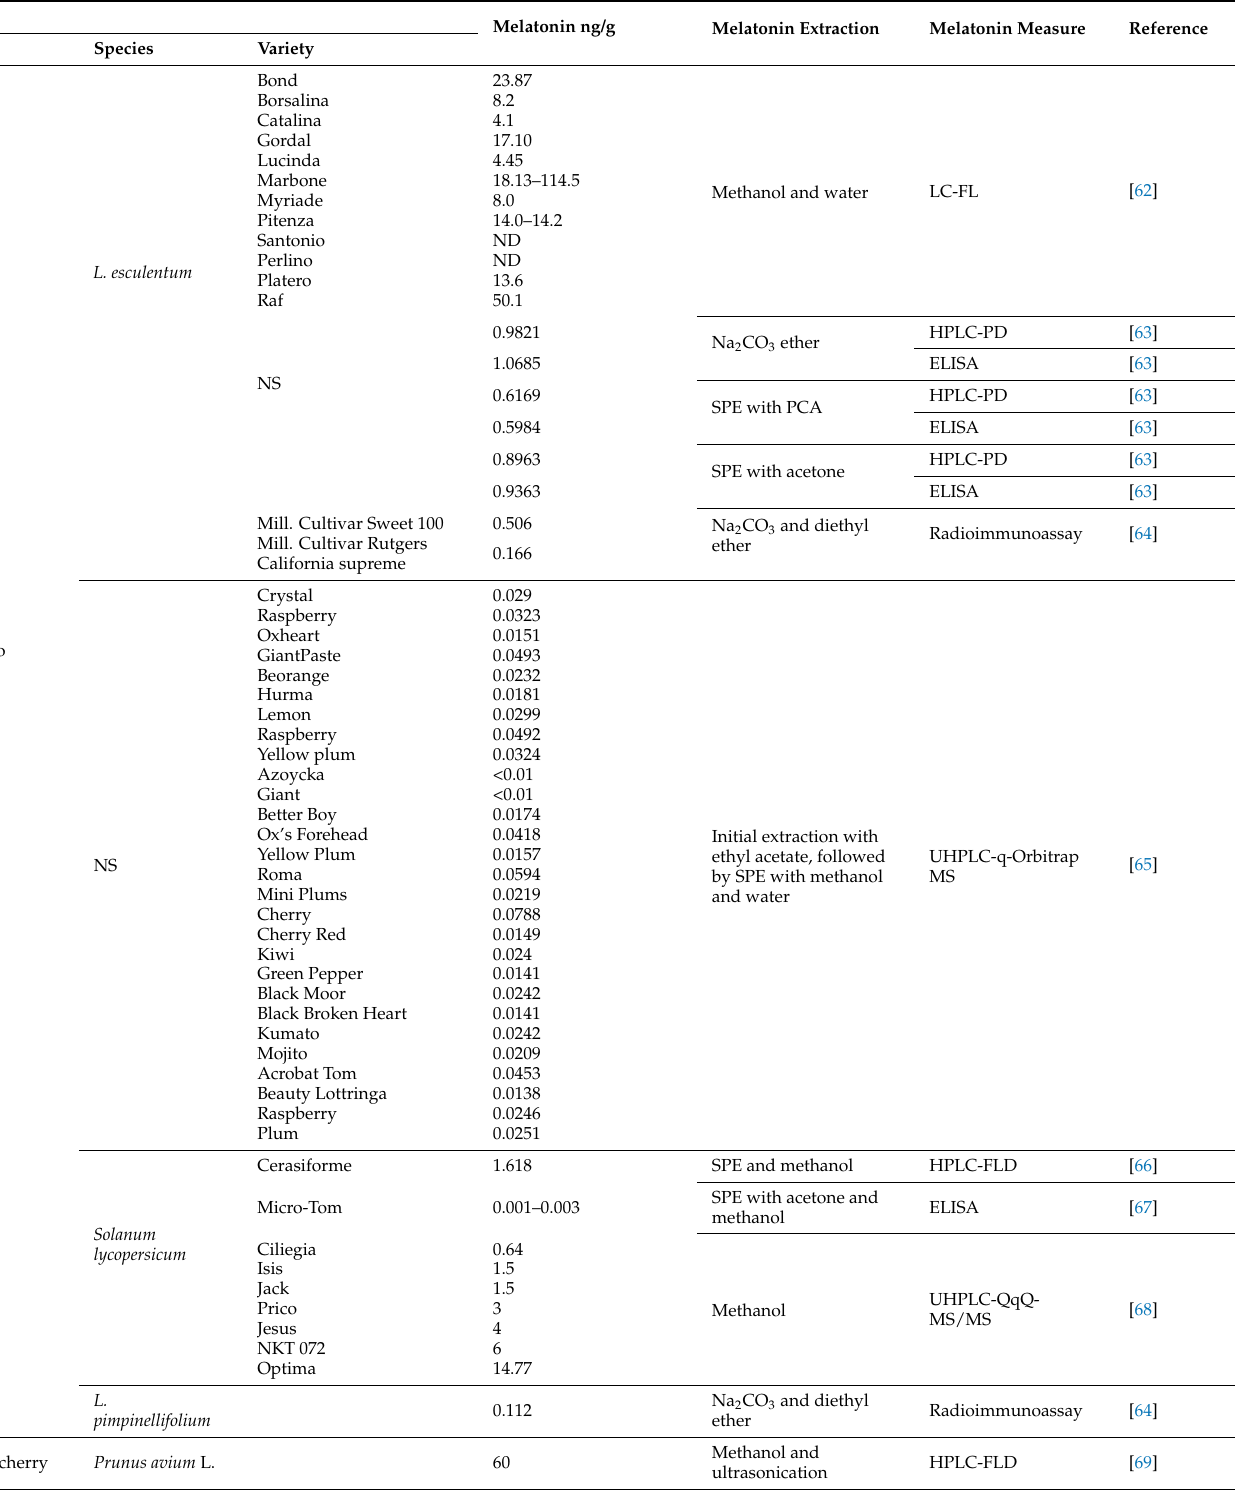
Table 2. Melatonin content in fruit and